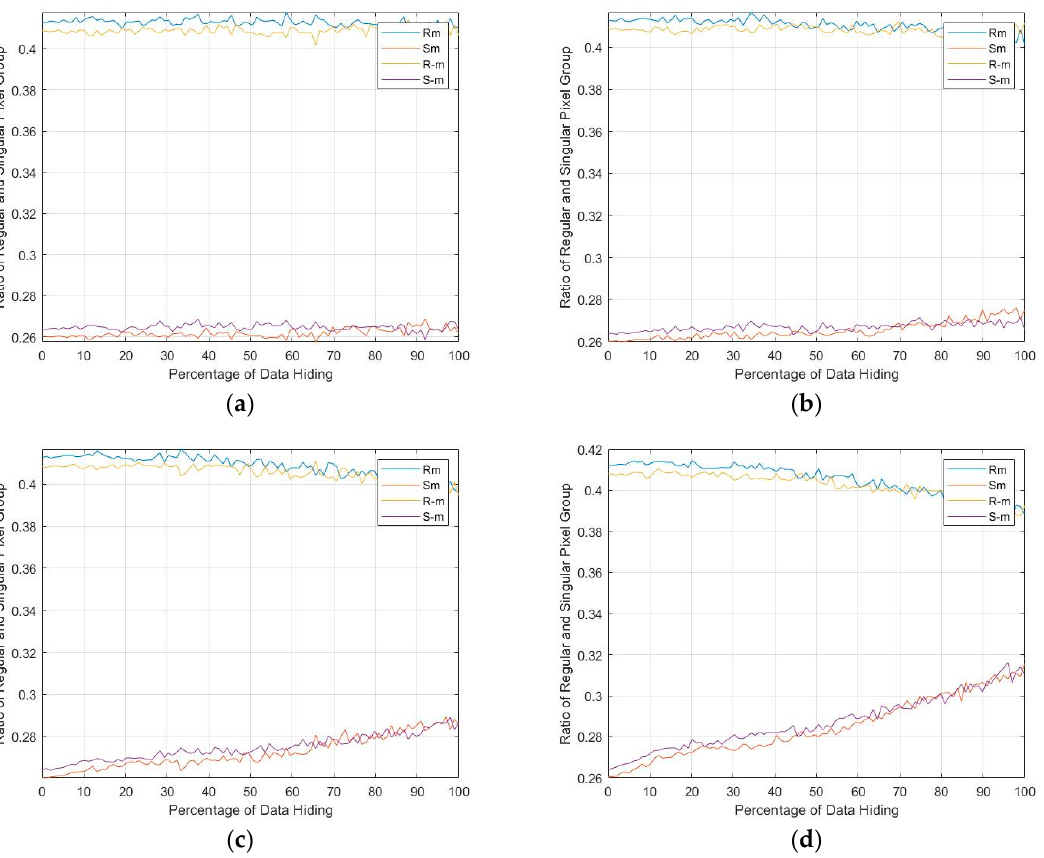
Figure 12. Comparisons of RS analysis for n =1 to 4 in grayscale Lena image. ( a ) n = 1; ( b ) n = 2; ( c ) n = 3; ( d ) n = 4.